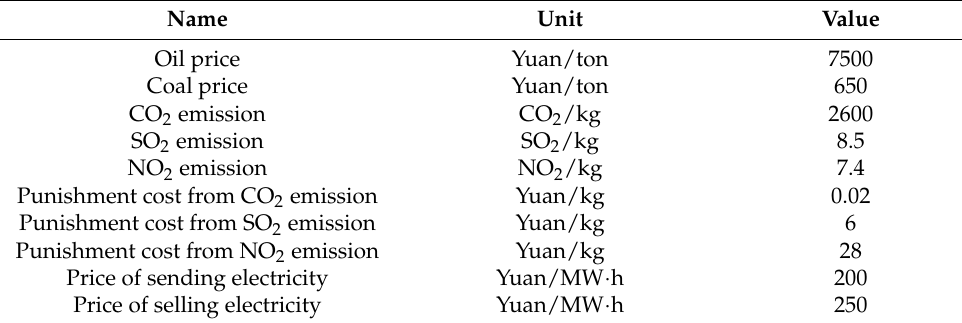
Table 2. Summary of parameter in the model optimization.